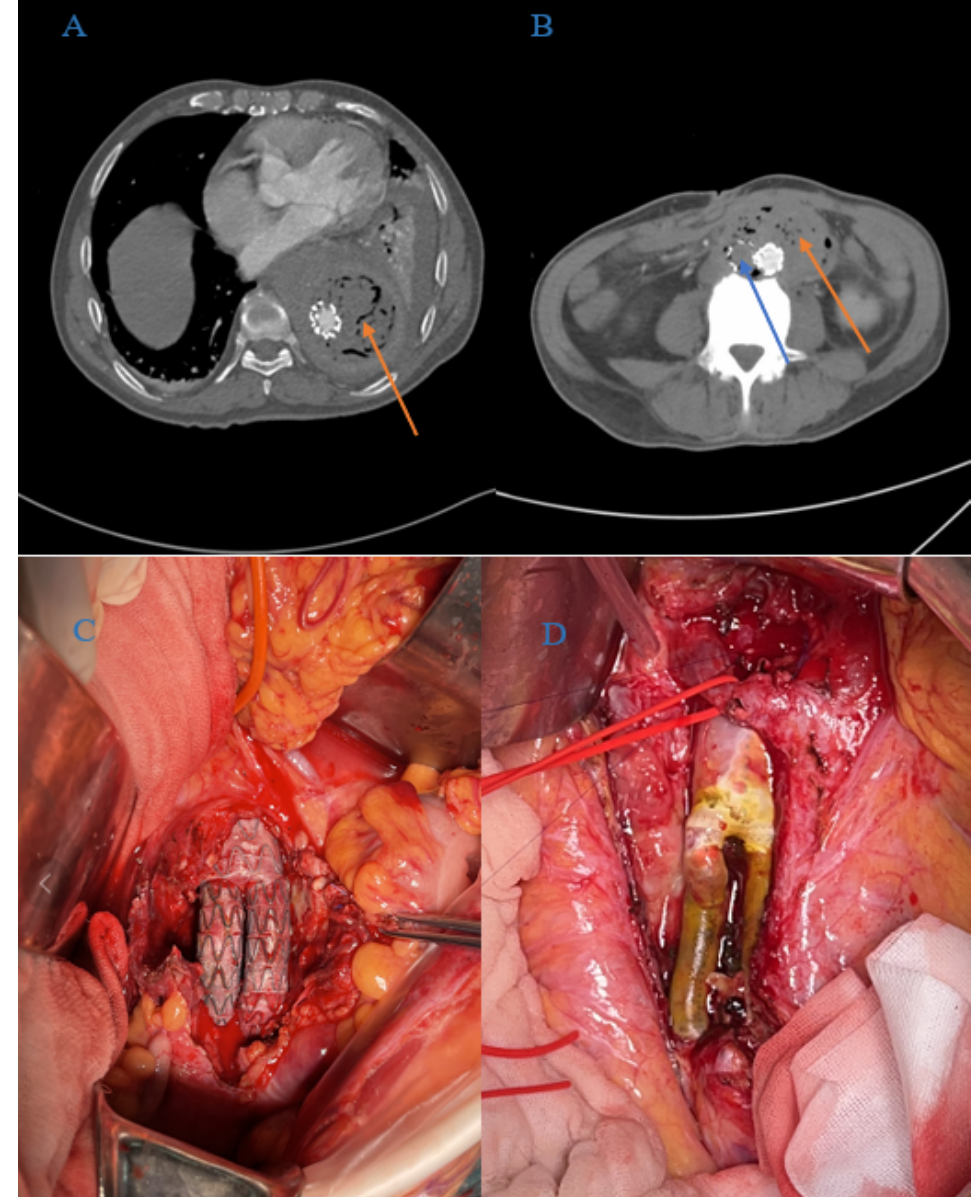
Figure 2. Peri-operative images of AGI patients. ( A ) Pre-operative CTA image of an AGI patient who previously underwent TEVAR (the orange arrow indicates the peri-graft fluid and gas). ( B ) Pre-operative CTA image of an AGI who underwent EVAR prior to AGI (orange and blue arrow indicate the peri-graft fluid and gas and graft thrombosis, respectively). ( C ) Peri-operative image of the